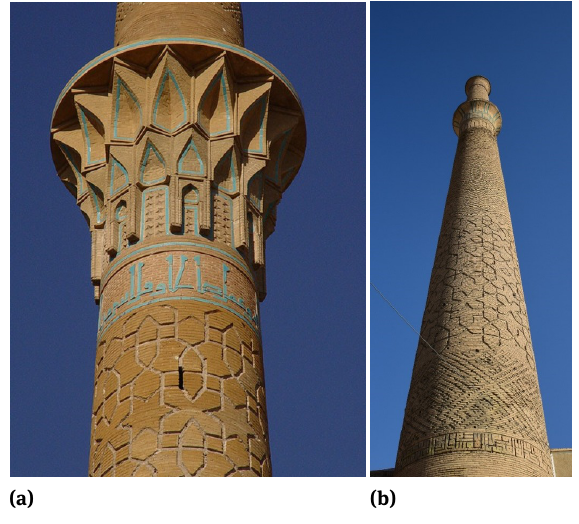
Figure 9: Minarets in the city of Isfahan; a) Sareban b) Masjed-Ali .